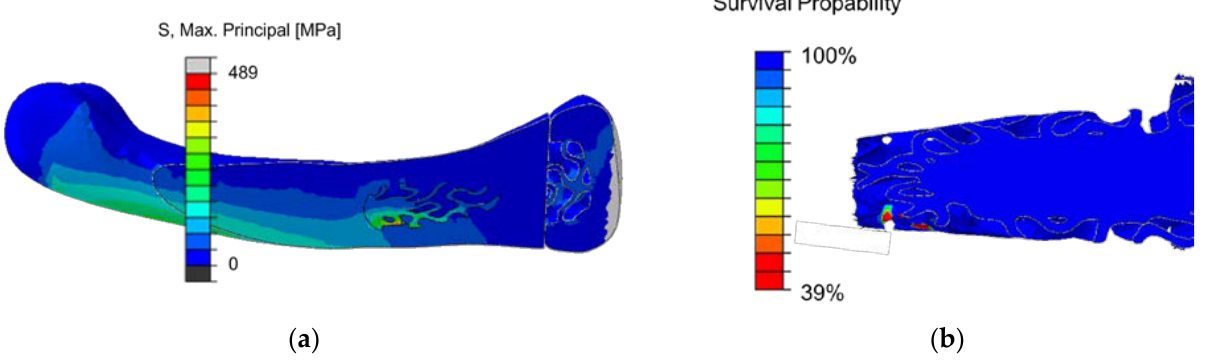
Figure 14. Index finger implant in proximal bone: ( a ) maximal principal stress when implant is loaded with 45° to bone axis with 2.5 times of 100N reference load; ( b ) probability of survival for each finite element of a defined region.